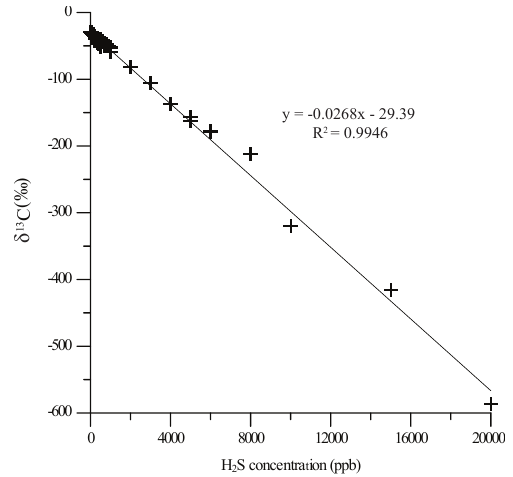
Figure 6. Isotopic signal from the Picarro G1101-i CRDS for 995ppm CO 2 with H 2 S concentrations ranging from 0 to 20000ppb (0–20ppm).